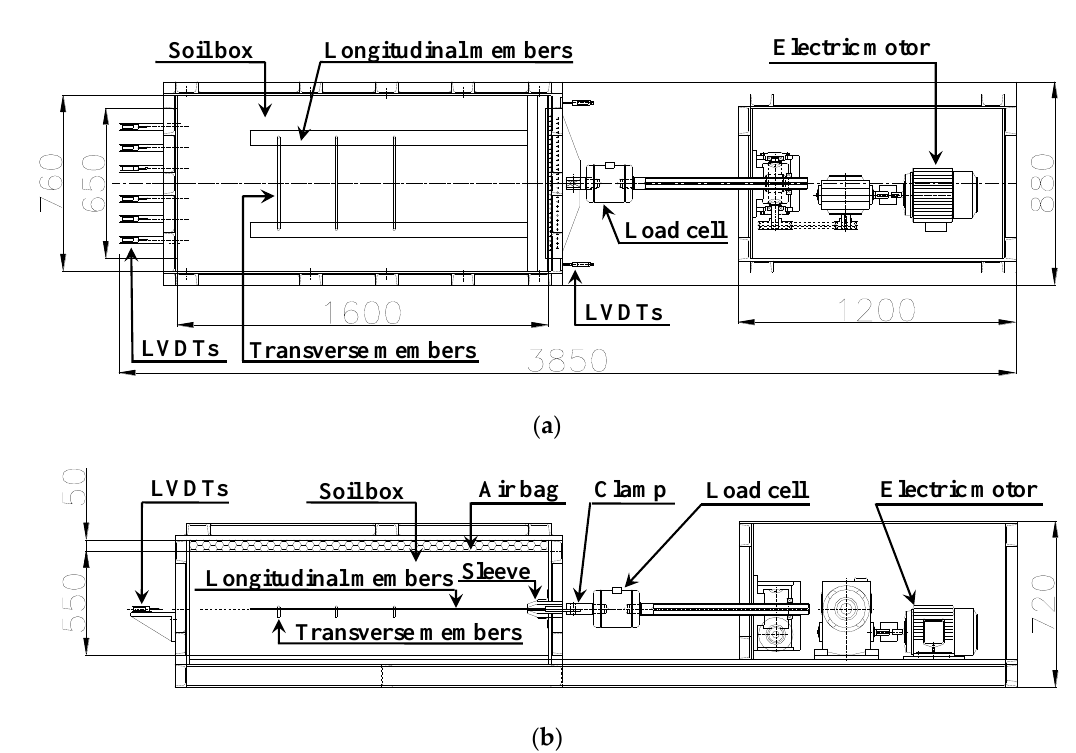
Figure 1. Schematic view of large-scale pullout test apparatus: ( a ) plan view and ( b ) cross-sectional view (dimensions in millimeters).